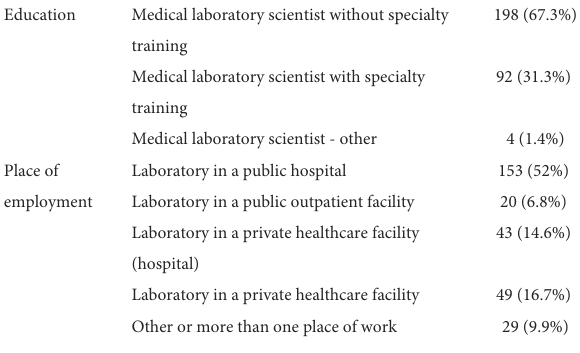
TABLE 2 Description of the surveyed population in stage 2 – quantitative survey ( N =